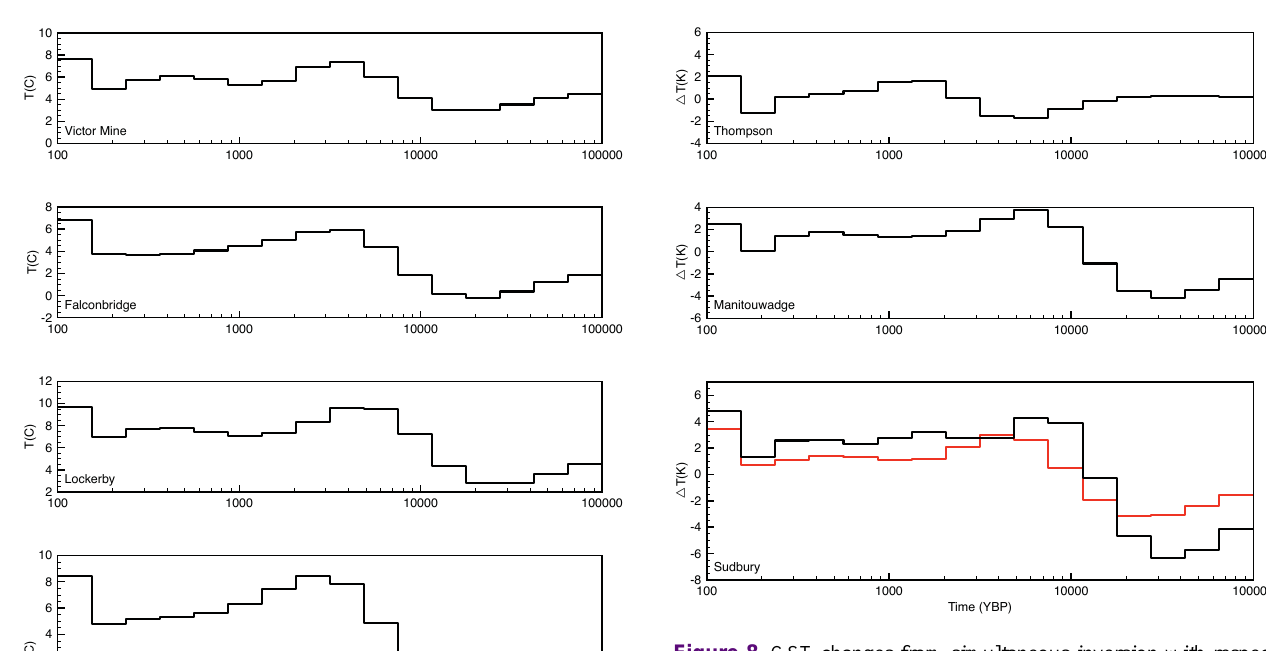
Figure 8. GST changes from simultaneous inversion with respect to the long-term temperature at 100 ka. The Sudbury GST changes include (black) and exclude (red) Craig Mine. Table 3. Summary of GST history results for simultaneous inver- sions where t min and t pgw are the occurrence of the minimal temper- ature and maximal temperature associated with postglacial warming and (cid:49)T is the temperature